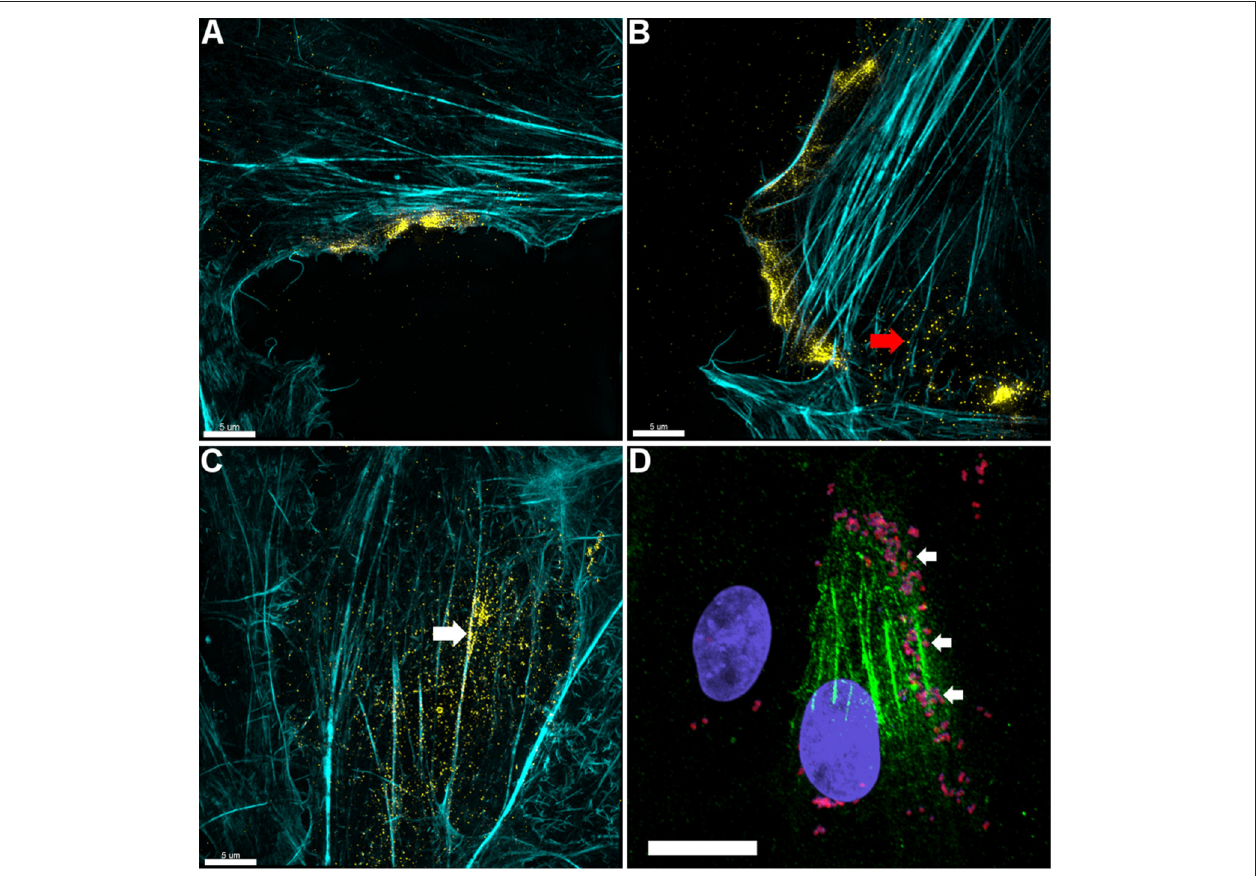
FIGURE 3 | Actin is expressed on the surface of PK-15 cell monolayers. (A–C) Localization of actin on the surface of PK-15 cells. Uninfected monolayers were grown to semi-confluency, fixed in methanol-free paraformaldehyde, incubated with mAb β − act prior to permeabilization, and conjugated to anti-murine CF TM 488 (yellow). F-actin was then stained using phalloidin (cyan) after permeabilization. Surface exposed actin can be seen accumulating at the leading edge (A,B) of cells in the monolayer as well as on the surface of cells along filaments that stained intensely with phalloidin (C) . Red arrow in (B) indicates what appears to be globular extracellular actin while the white arrow in (C) demonstrates extracellular actin that appears to colocalize with F-actin. (D) M. hyopneumoniae cells adhere on the surface of PK-15 cells in regions enriched with surface actin. M. hyopneumoniae cells (magenta colored cells indicated by white arrows) were labeled with F2 P94 − J antisera conjugated to CF TM 568 (red) and in this case, surface actin appears green. The nuclei of M. hyopneumoniae and PK-15 cells were stained with DAPI (blue). Scale bars in (A–C) are 5 and 20 µ m in (D)